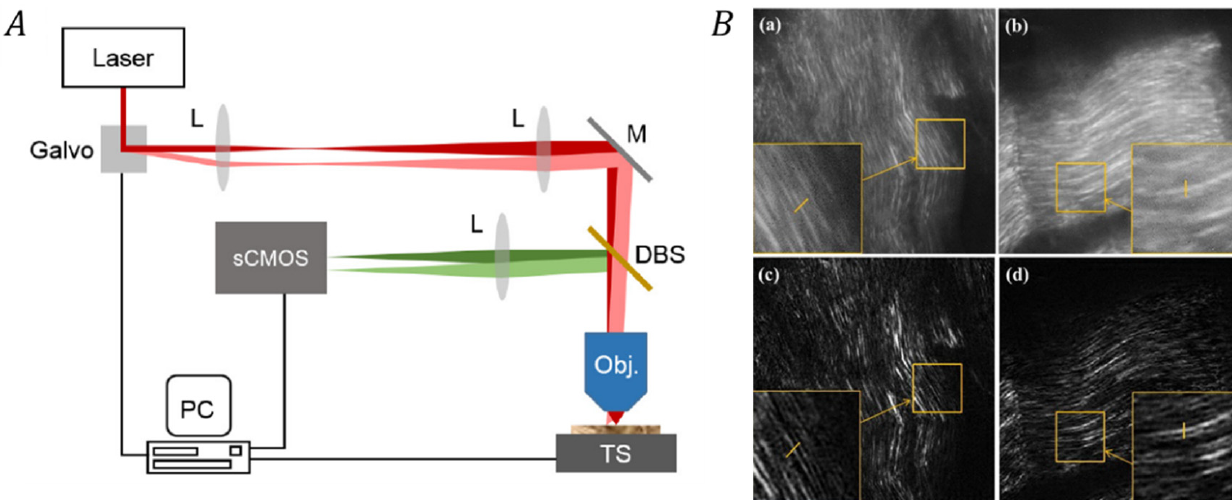
Figure 9. Correlative SHG-SIM for thick sample imaging [98]. ( A ) SHG-SIM setup schematic. The only difference between SHG and 2P-SIM is that in the former, the backward objective lens collects the excited SHG signal. ( B ) Traditional SHG and SHG-SIM imaging comparison. ( a , b ) Traditional SHG images of the chicken tendon aligned along the x -direction and y -direction, respectively. ( c , d ) SHG-SIM images showing the views in ( a , b ), respectively. SHG-SIM allows visualization of the microfilament structure of the chicken tendon. Copyright 2018 Biomed Opt